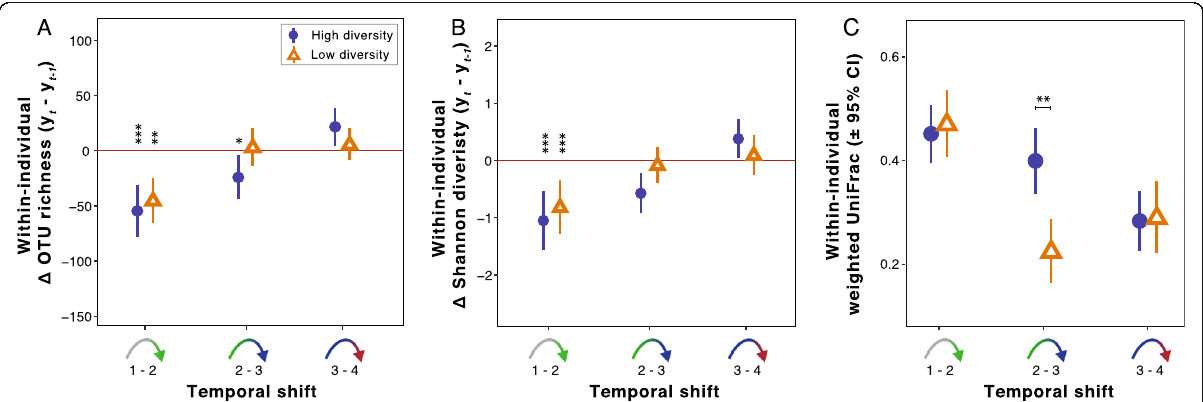
Fig. 3 Temporal shifts in host-associated microbiota characteristics across experimental treatment and sampling moments. Average within- individual differences (± 95% CI whiskers) of ( a ) OTU richness, ( b ) Shannon ’ s diversity and ( c ) weighted UniFrac distance between consecutive sampling moments, presented for each temporal shift (bicolored arrows) and stratified by experimental treatment (closed circle = high diversity, open triangle = low diversity). Associated statistics are detailed in Tables 3 and